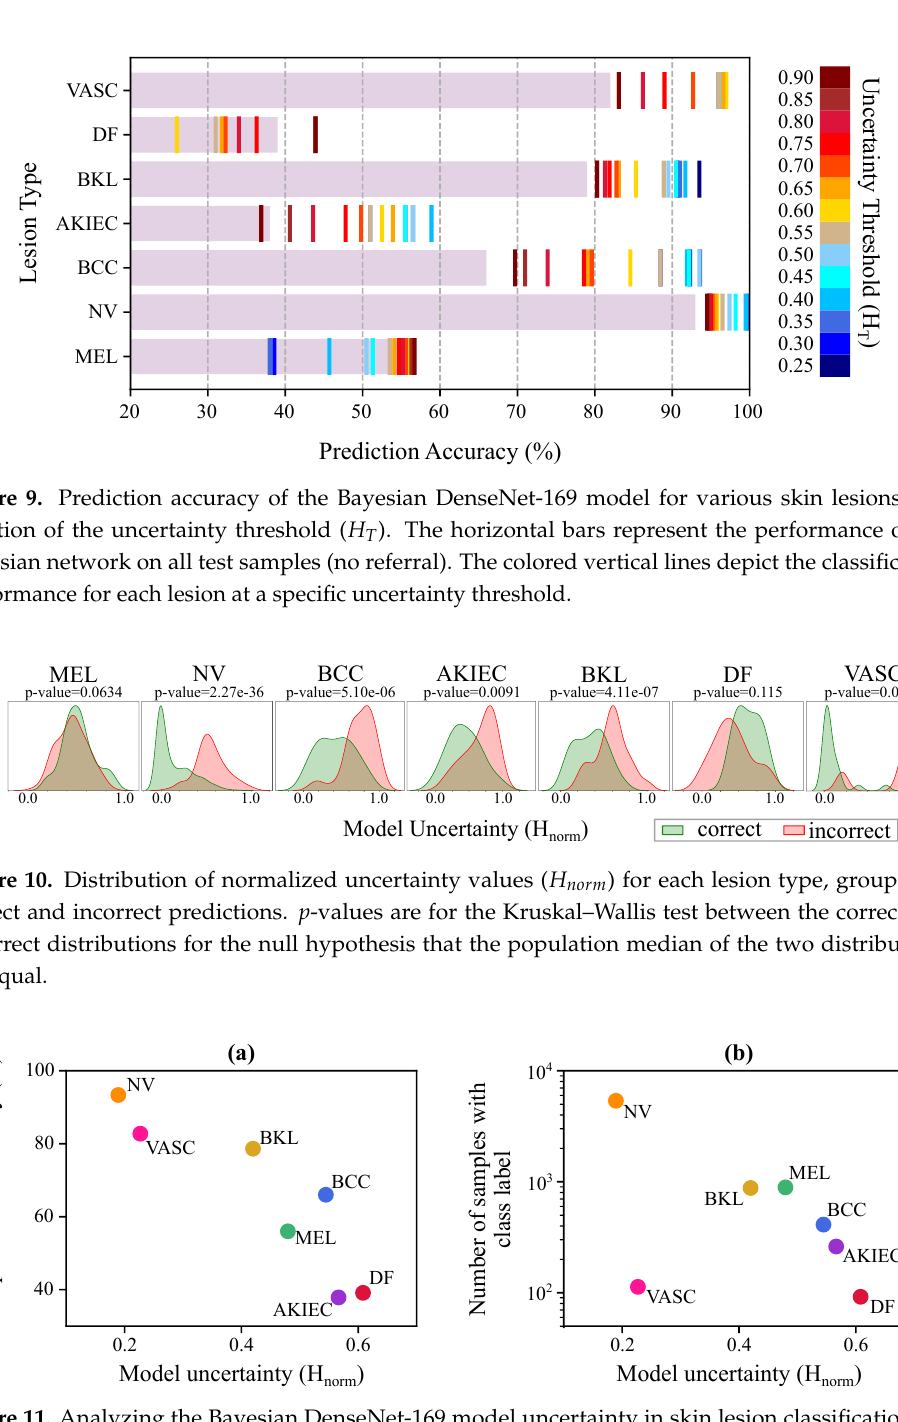
Figure 11. Analyzing the Bayesian DenseNet-169 model uncertainty in skin lesion classification. ( a ) Bayesian DenseNet prediction performance as a function of mean model uncertainty for each class. ( b ) Number of training samples in each class as a function of mean model uncertainty for each